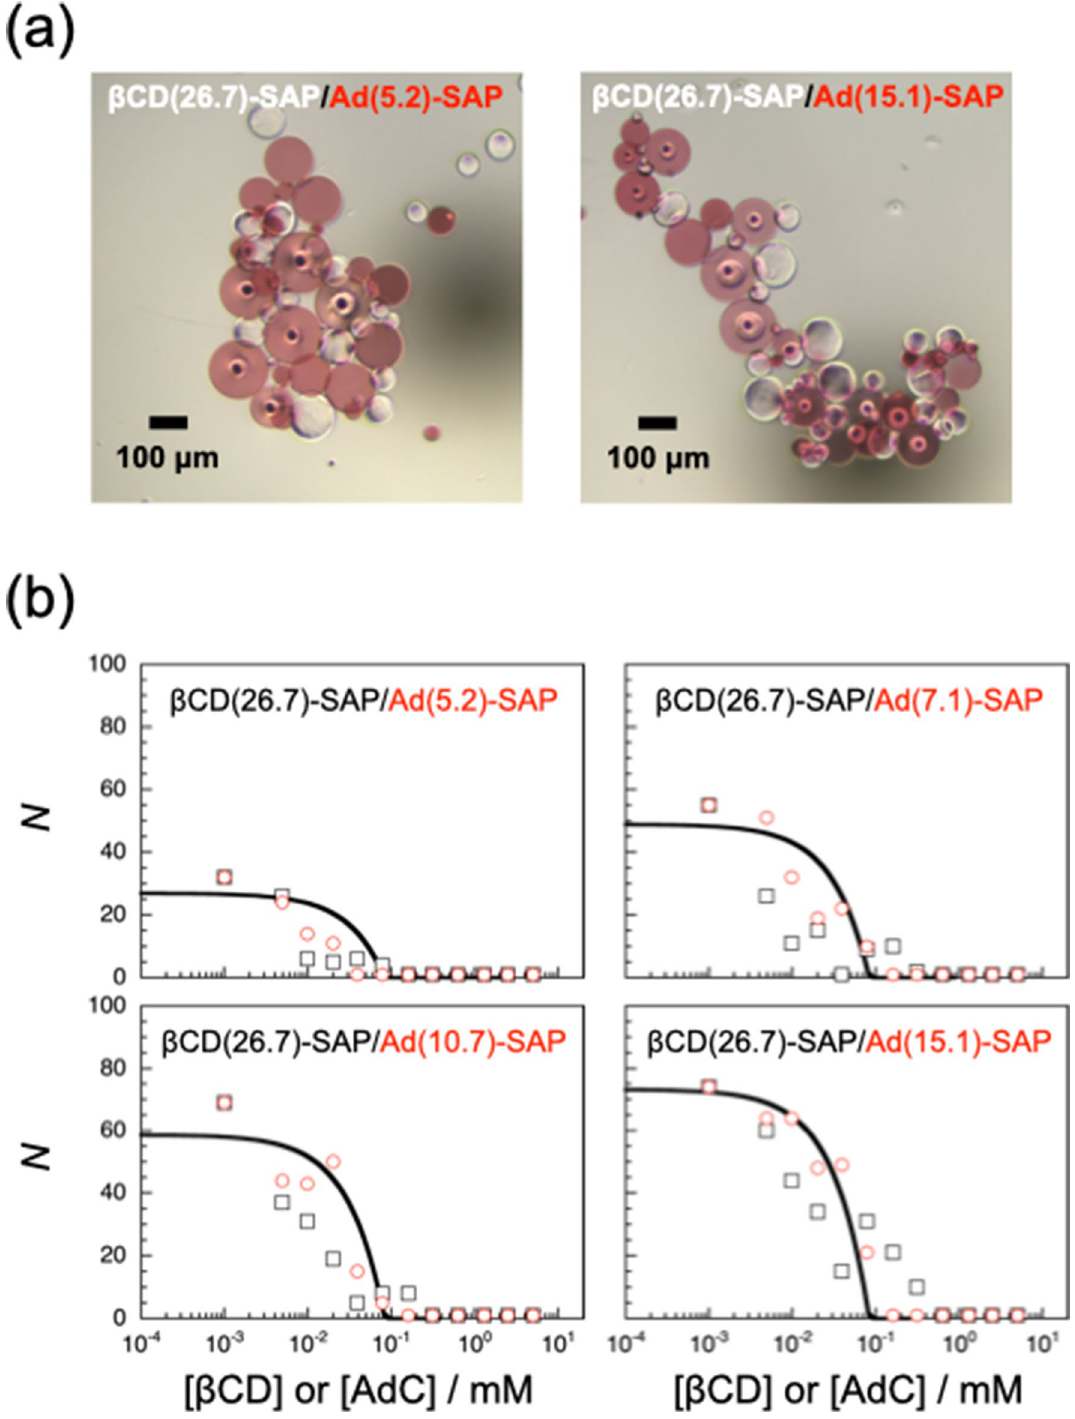
Figure 2. Interaction of βCD(26.7)-SAP and Ad( y )-SAP microparticles. ( a ) A typical example of optical micrographs for assemblies formed from βCD(26.7)-SAP and Ad(5.2)-SAP microparticles, and from βCD(26.7)-SAP and Ad(15.1)-SAP microparticles. ( b ) The number ( N ) of SAP particles in βCD(26.7)-SAP/ Ad( y )-SAP assemblies in the presence of βCD (black square) and AdC (red circle). The curves are drawn based on the simplified model we proposed previously 37